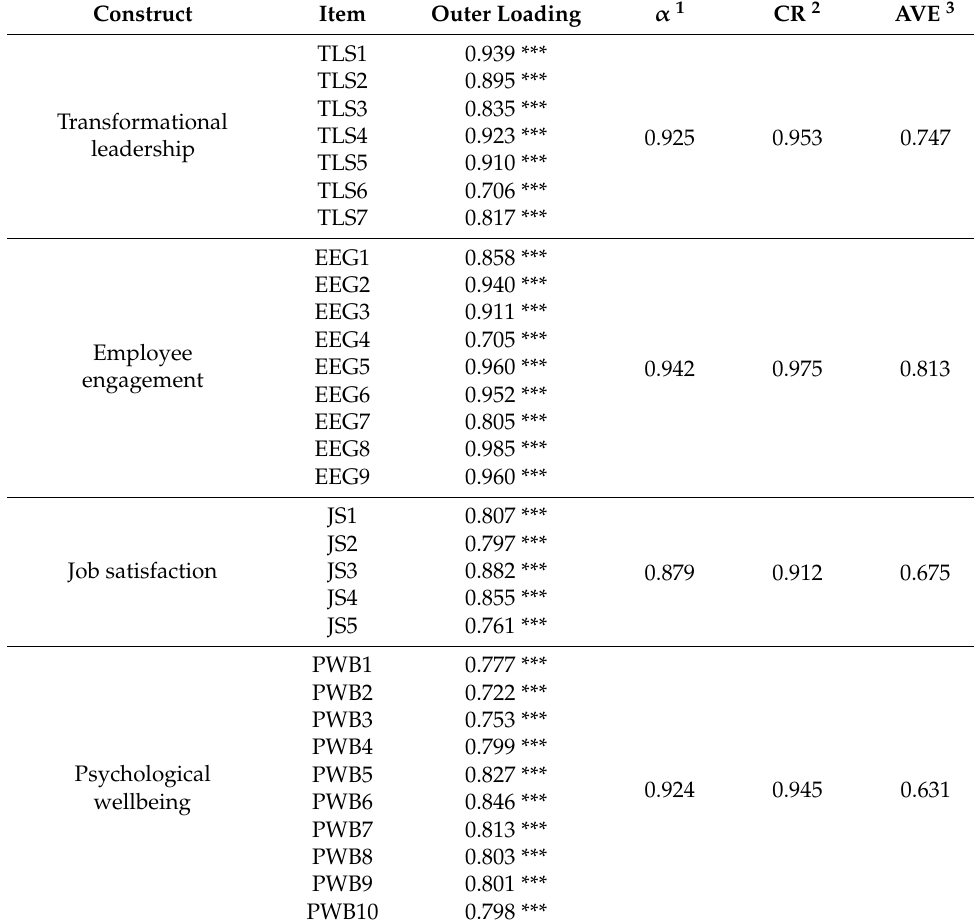
Table 2. The properties of reliability and validity of the study’s constructs. Construct Item